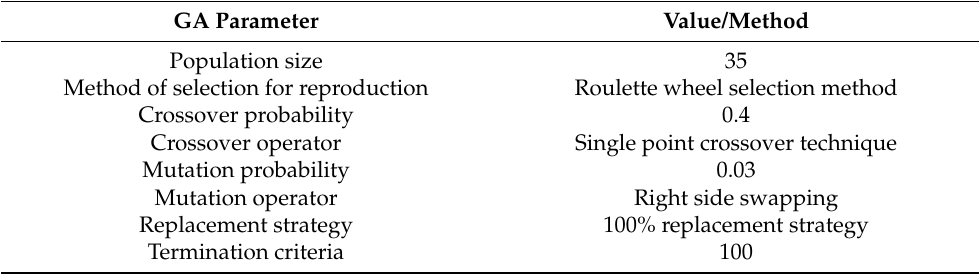
Table 4. GA parameters for optimizing ANFIS